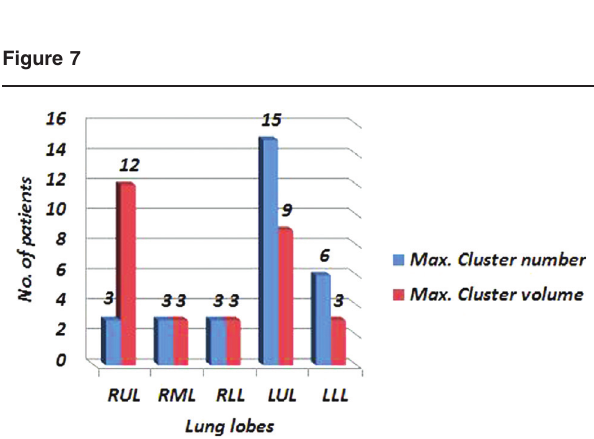
The results of the Goddard score in comparison with GOLD scoring.